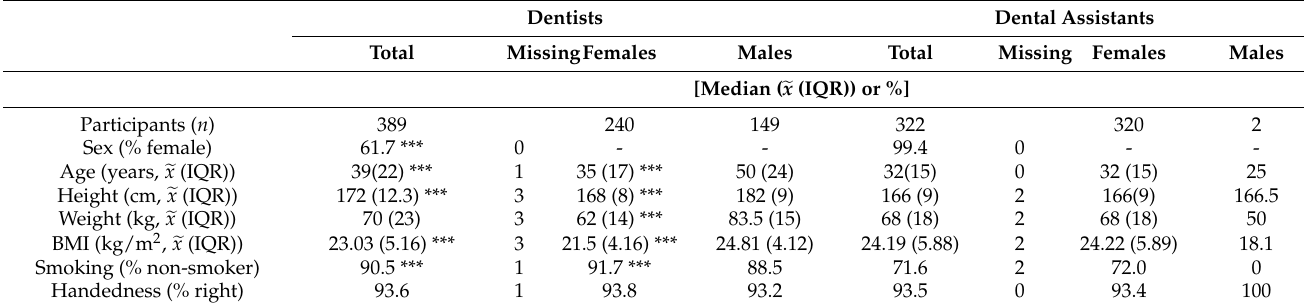
Table 1. Individual characteristics of the participants.